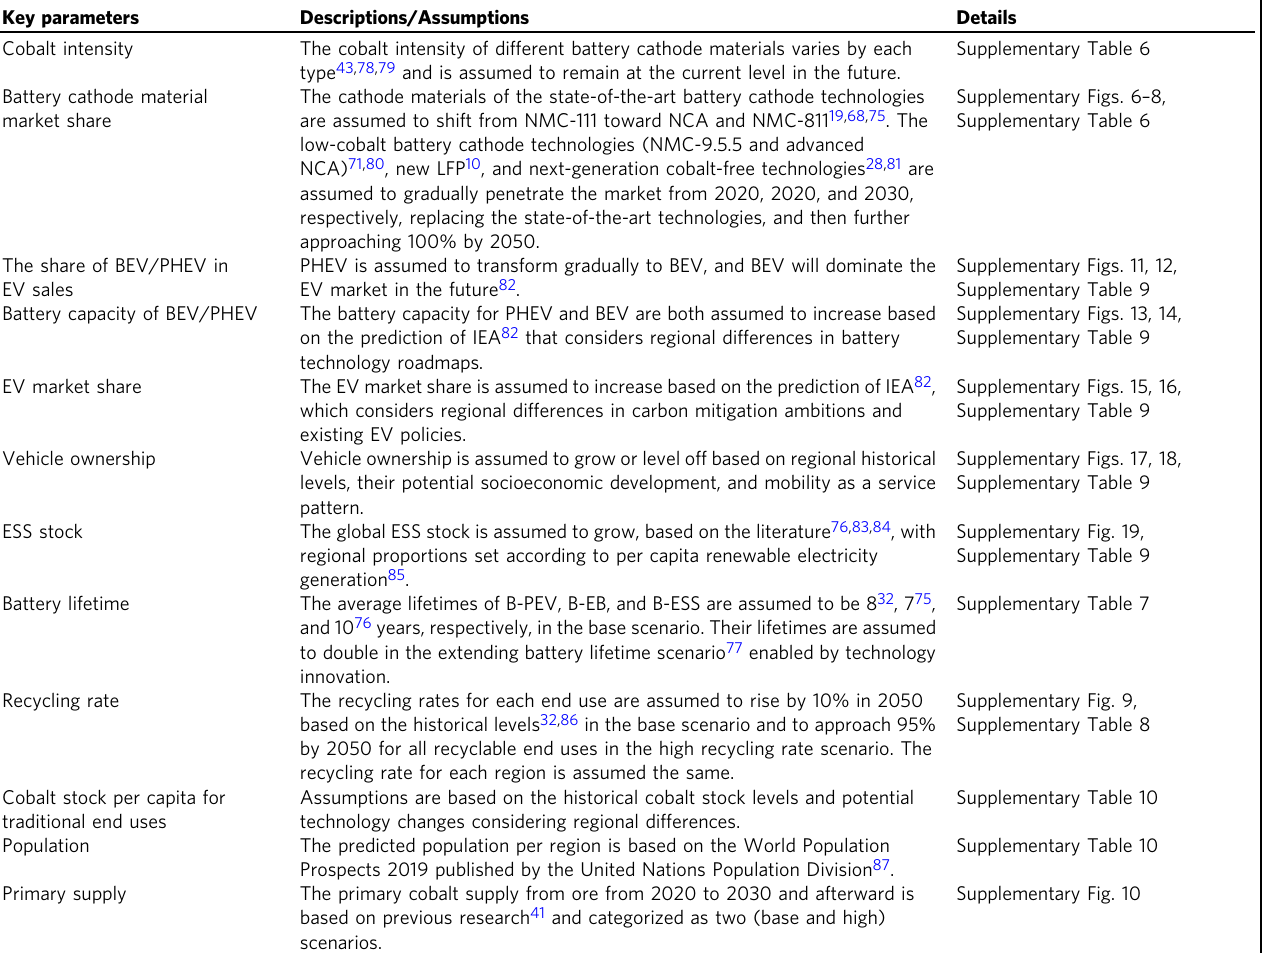
Table 1 Description and assumptions of key model